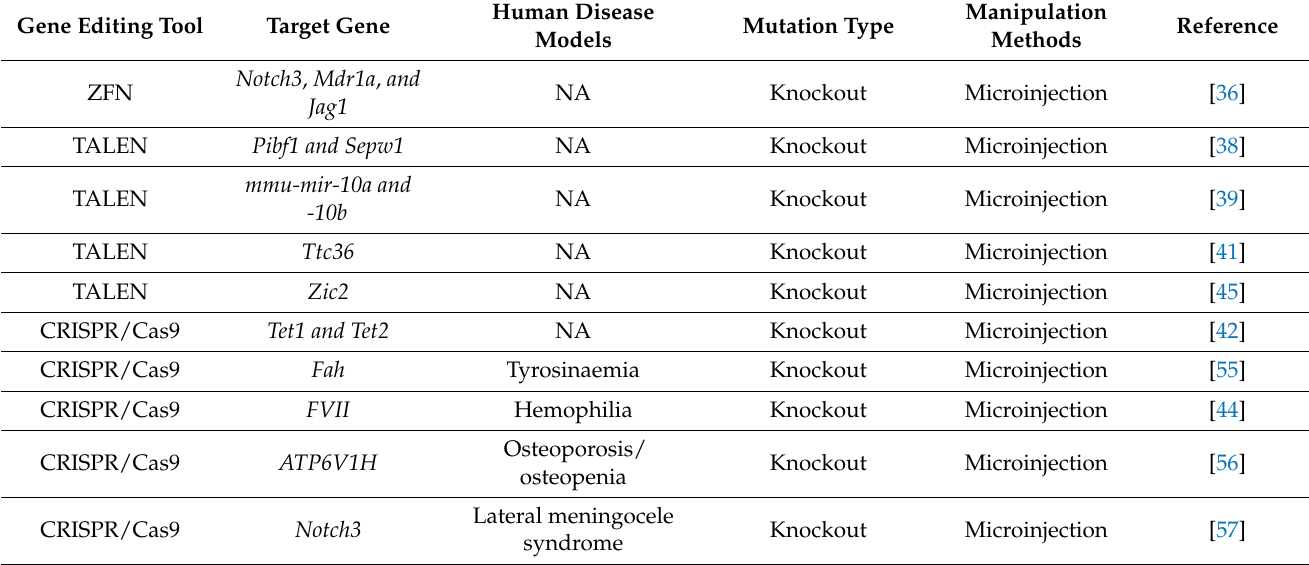
Table 1. Generation of mouse models using gene editing tools. NA: not available, without information of related diseases in